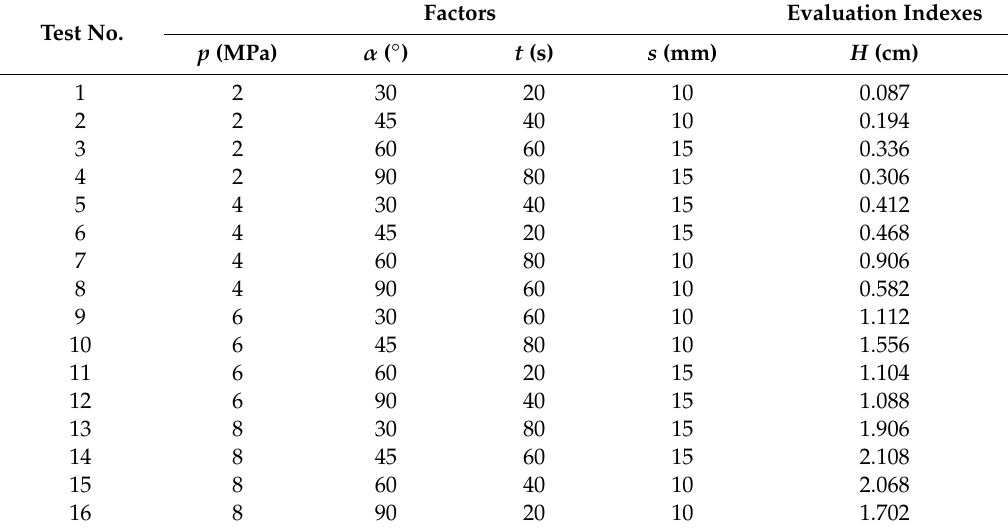
Table 2. Results of the hybrid orthogonal test L 16 (4 3 × 2 1